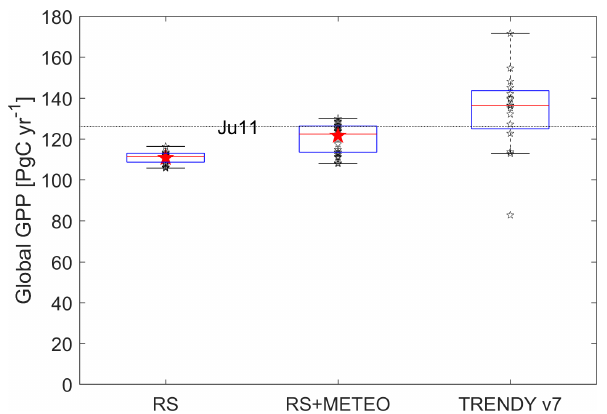
Figure 4. Global GPP for FLUXCOM and TRENDY ensembles for the period 2008–2010. The box plots show the median (red line), in- terquartile range (box) and total range (whiskers) of non-outliers (within median ± 1 . 5 interquartile range) of individual ensemble members (open black stars). The filled red star presents the value of the ensemble product (not available for TRENDY). The estimate of Ju11 is plotted as the horizontal broken